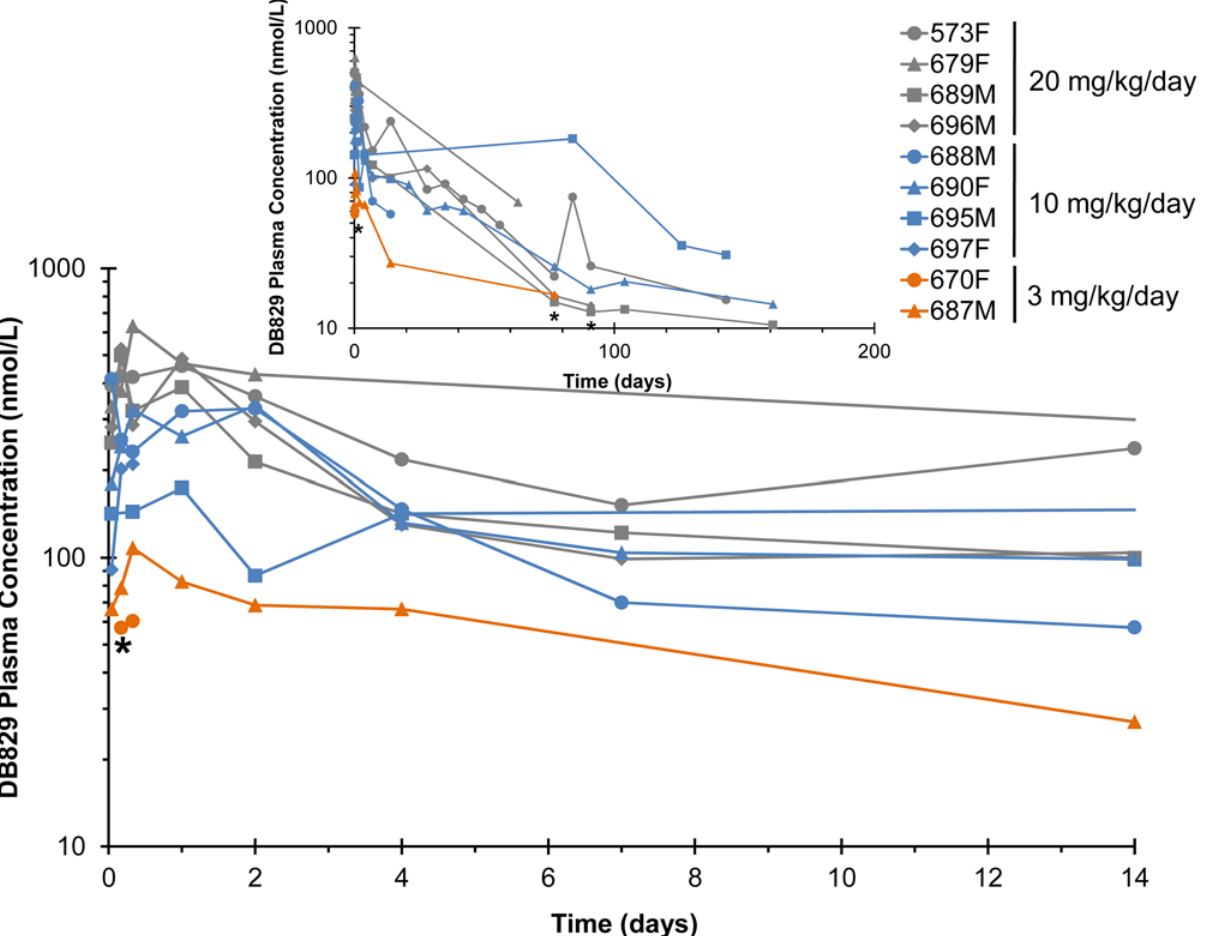
Fig 9. Plasma concentration-time profiles of DB829 following administration of the diamidine prodrug DB868 to infected vervet monkeys. Monkeys confirmed to have second stage HAT were administered DB868 orally, beginning at 28 days post-infection with T. b. rhodesiense KETRI 2537, at 20, 10 or 3 mg/kg/day for 10 consecutive days. The inset graph shows the extended profile out to the end of the study. * denotes the time that monkey 670 (1 day post- last drug dose), monkey 687 (82 days post-last drug dose) and monkey 696 (130 days post-last drug dose) were euthanized due to clinical morbidity. F, female; M,